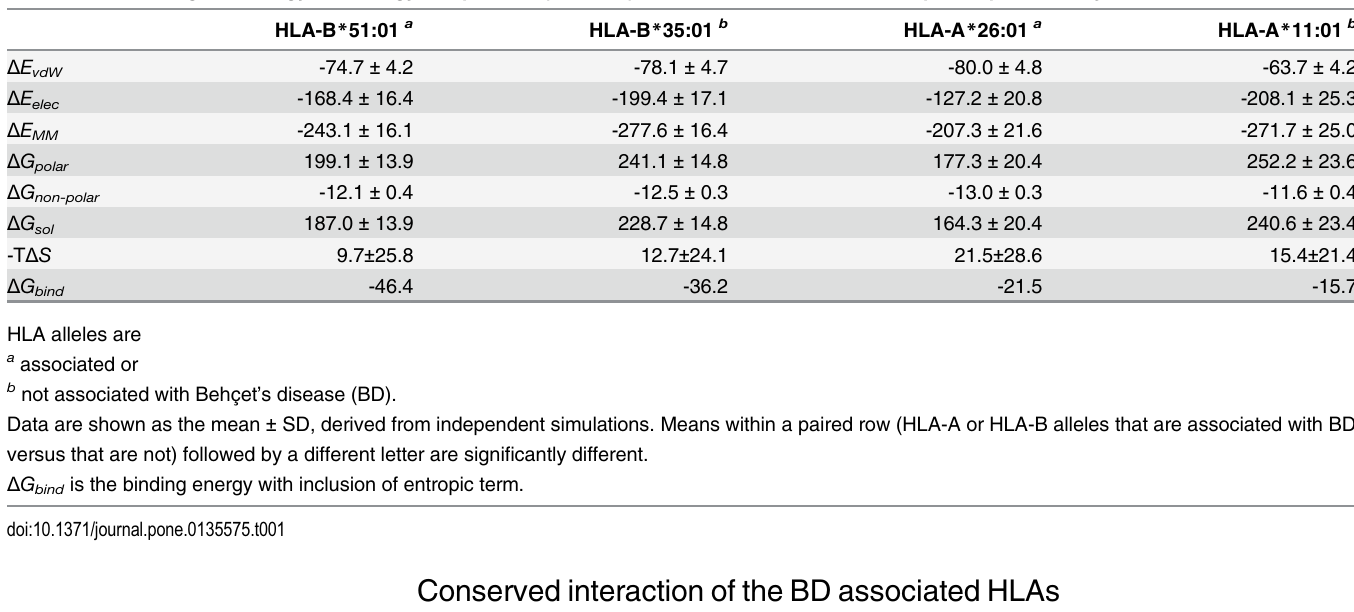
Table 1. The binding free energy and energy components (kcal/mol) for the four HLA/MICA-TM complexes predicted by the MM/PBSA method.